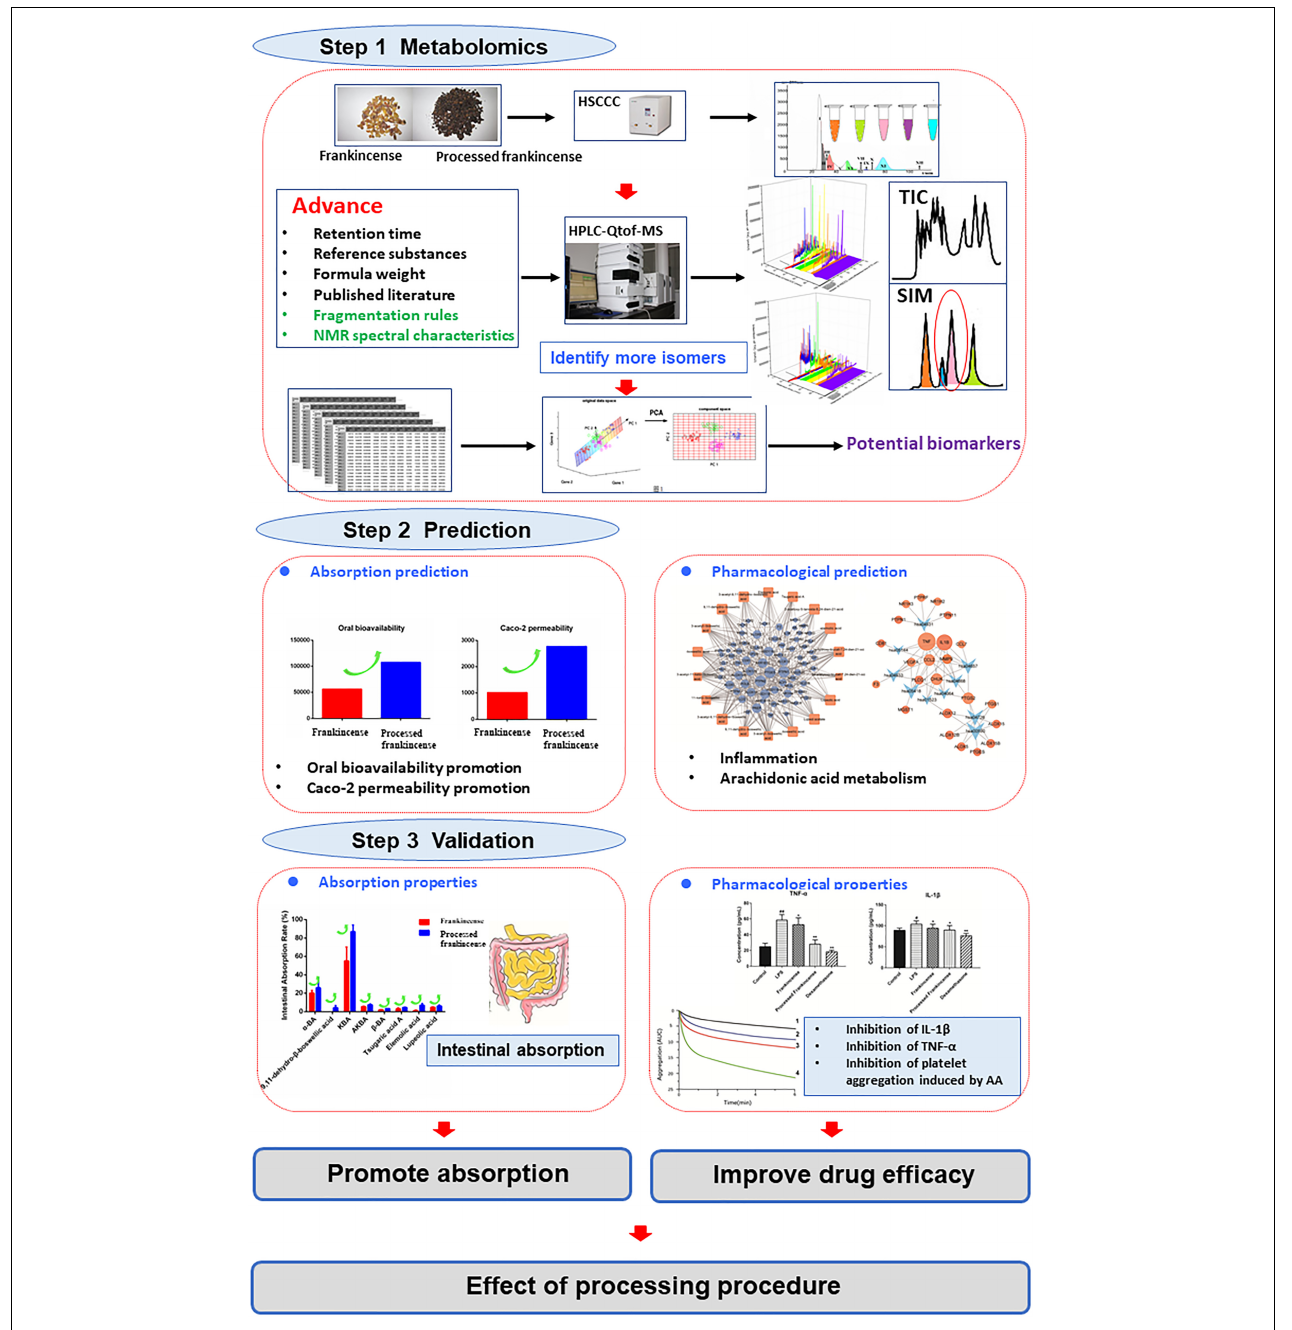
FIGURE 5 | Description of the